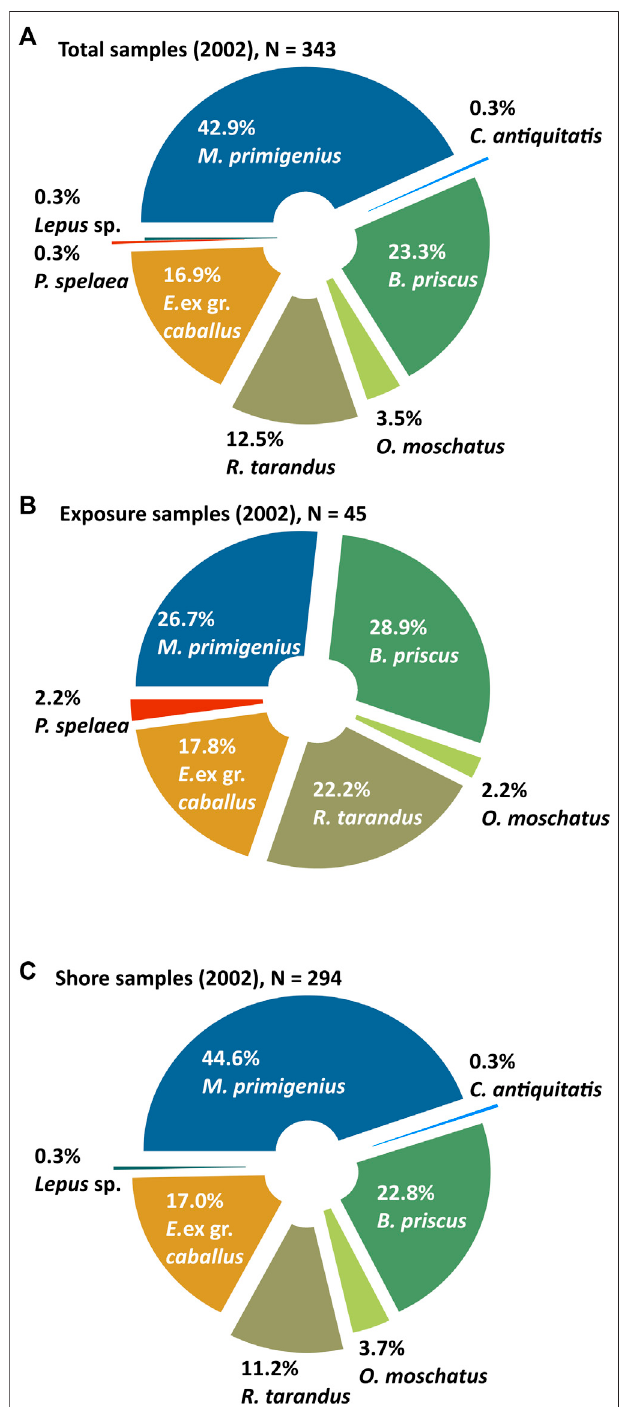
FIGURE 6 | Composition of the mammal bone collections from Oyogos Yar showing (A) the total collection from 2002 (N = 343) differentiated into (B) the exposurecollection(N=45)and (C) theshorecollection(N=294).Thepercentages are calculated from the total number of identi fi ed samples ( Table 1 ).